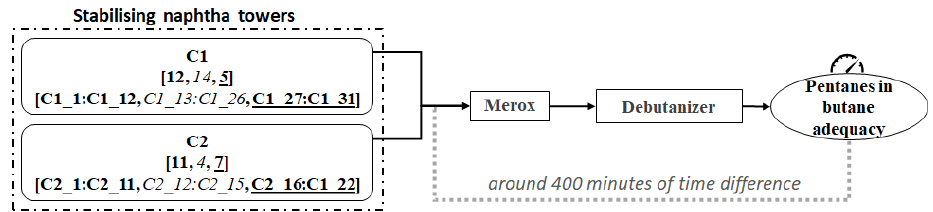
Figure 1. High-level diagram of the analysed process. Columns C1 and C2 in Figure 1 represent two different stabilising naphtha